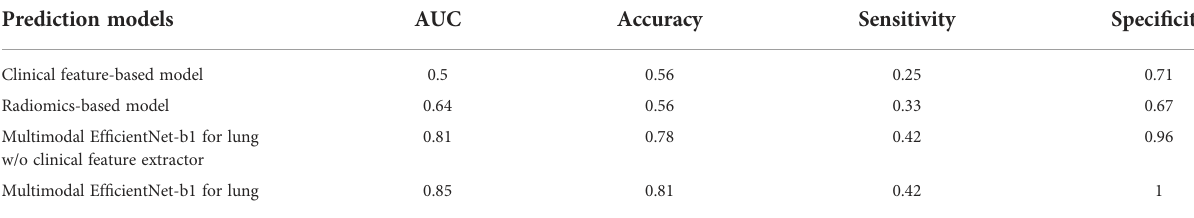
TABLE 3 Comparison of prediction model performances for the test set of the primary cohort. Prediction